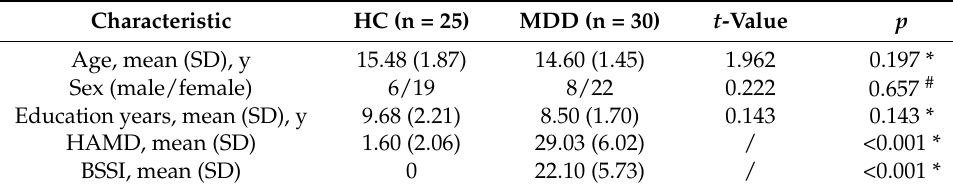
Table 2. Demographics and clinical characteristics between MDDs and HCs. Characteristic